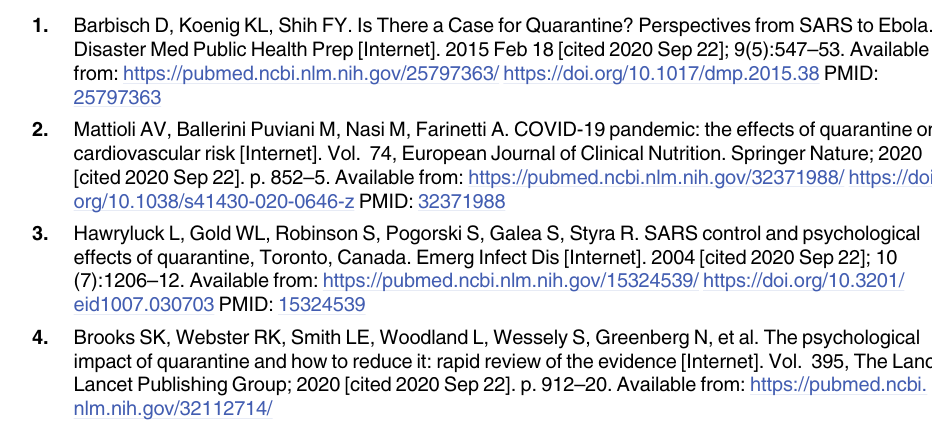
S2 Table. Linear regression of HADS-anxiety. S3 Table. Linear regression of HADS-depression. S4 Table. HADS-anxiety estimated marginal means (EMMs) by levels of physical activity. S5 Table. HADS-depression estimated marginal means (EMMs) by levels of physical activ-